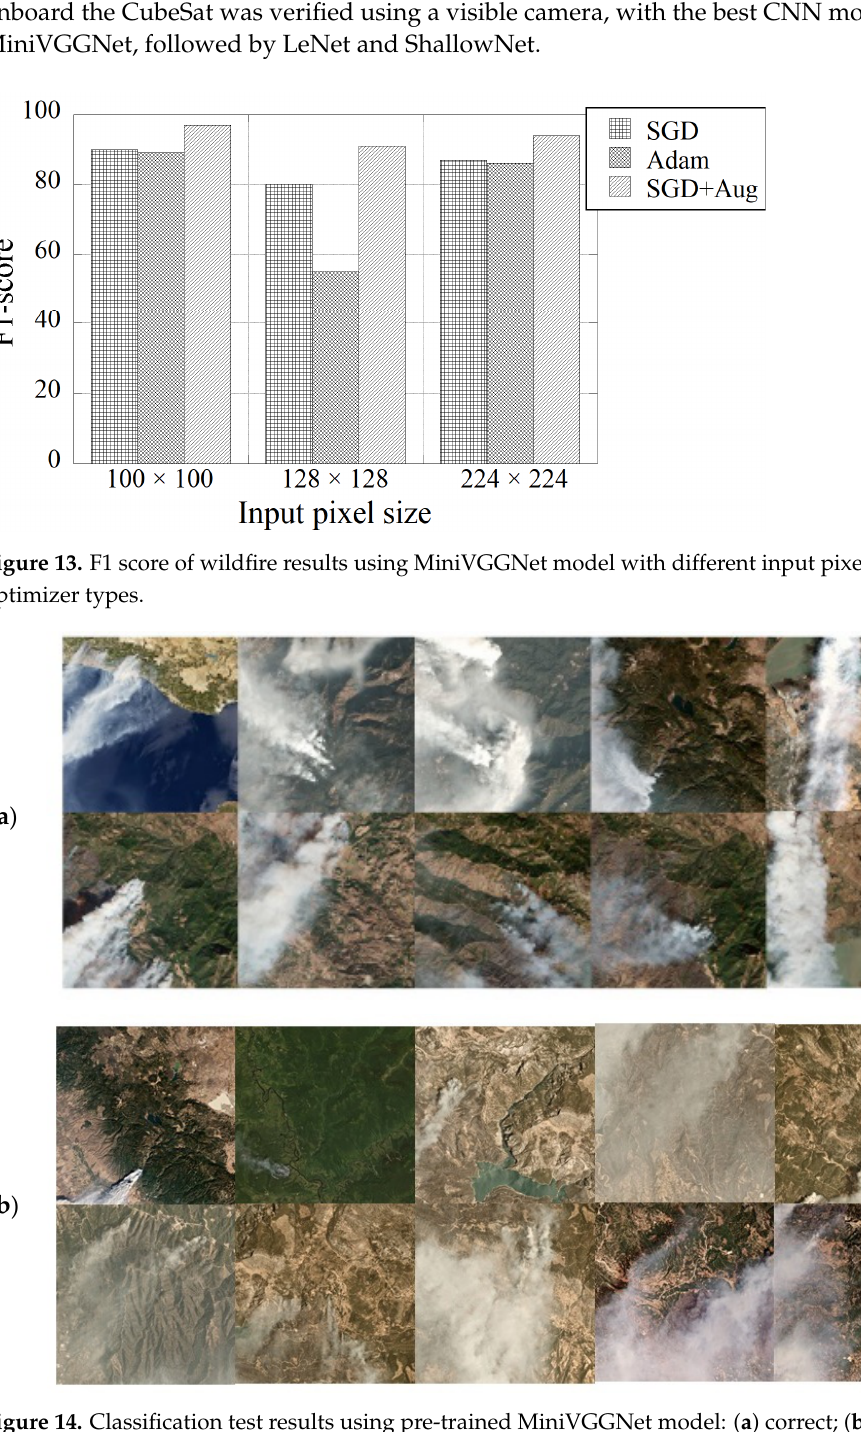
Figure 14. Classification test results using pre-trained MiniVGGNet model: ( a ) correct; ( b ) incorrect predictions.